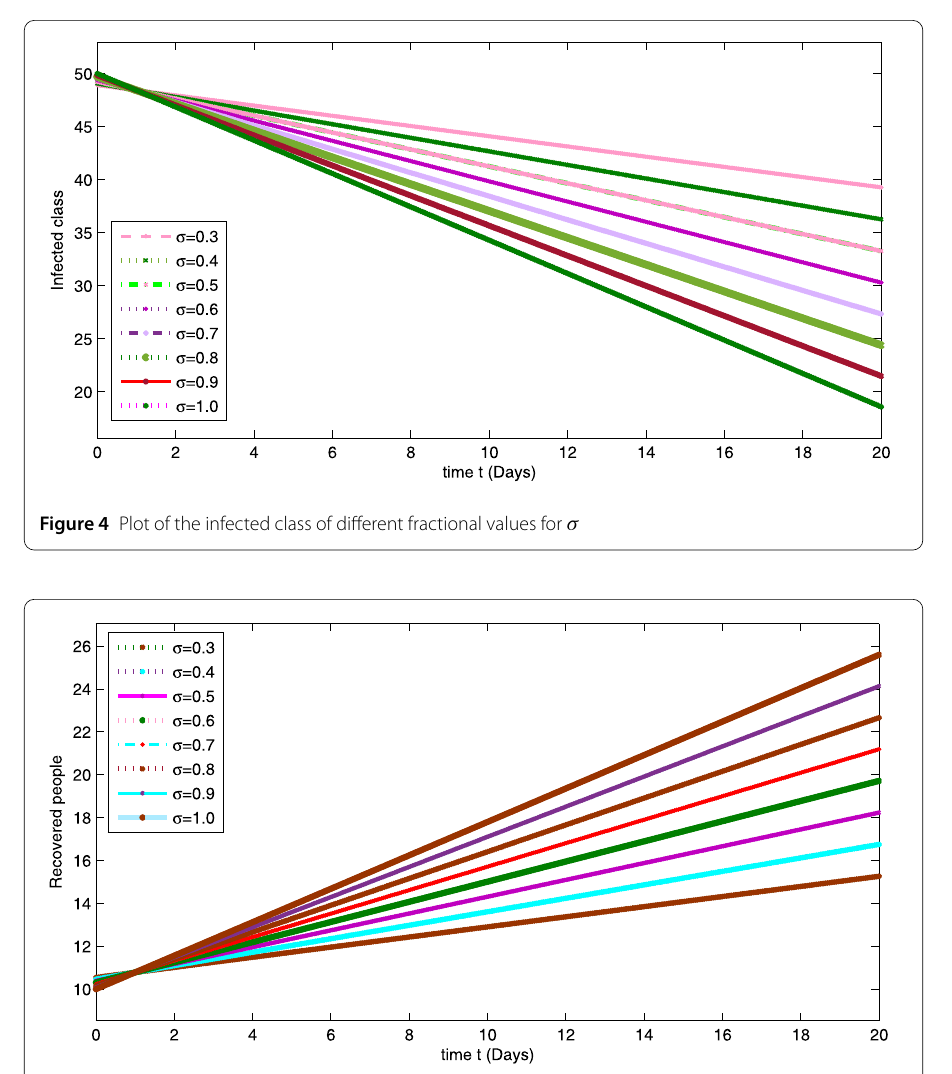
Figure 5 Plot of the recovered class of different fractional values for